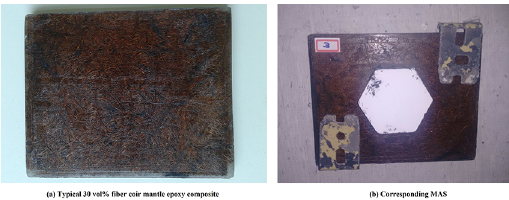
Figure 3. Typical 30 vol% fiber coir mantle epoxy composite (a) and the corresponding MAS (b).